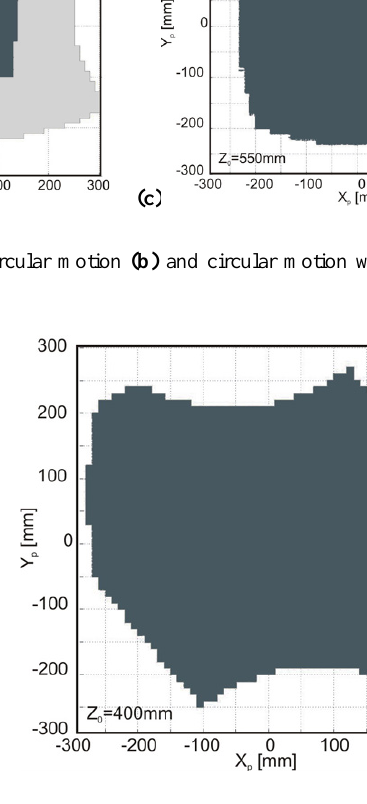
Figure 13. Grasping behavior for object orientation φ = 45 ◦ and wrist joint configuration I.